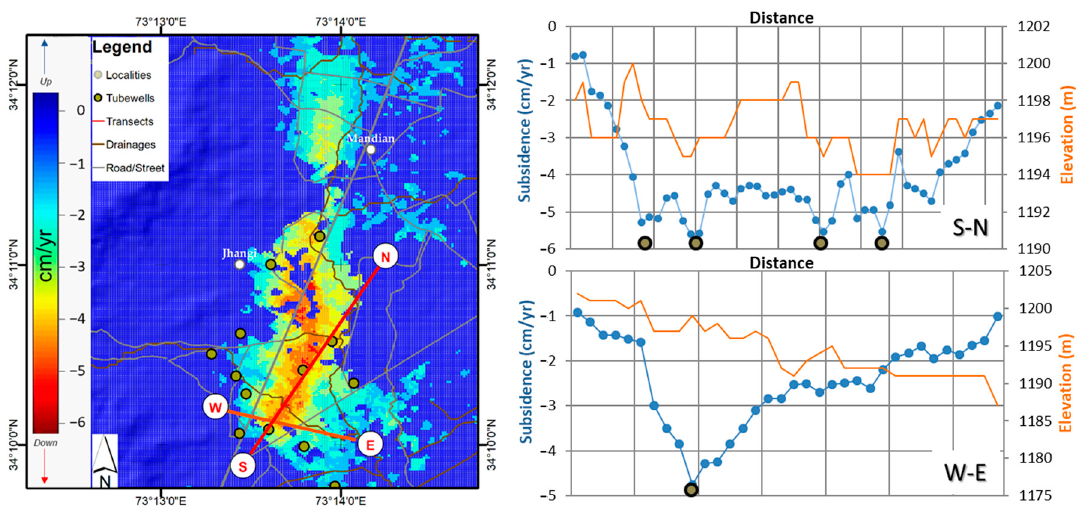
Figure 9. Subsidence profile along the S–N and W–E transects.